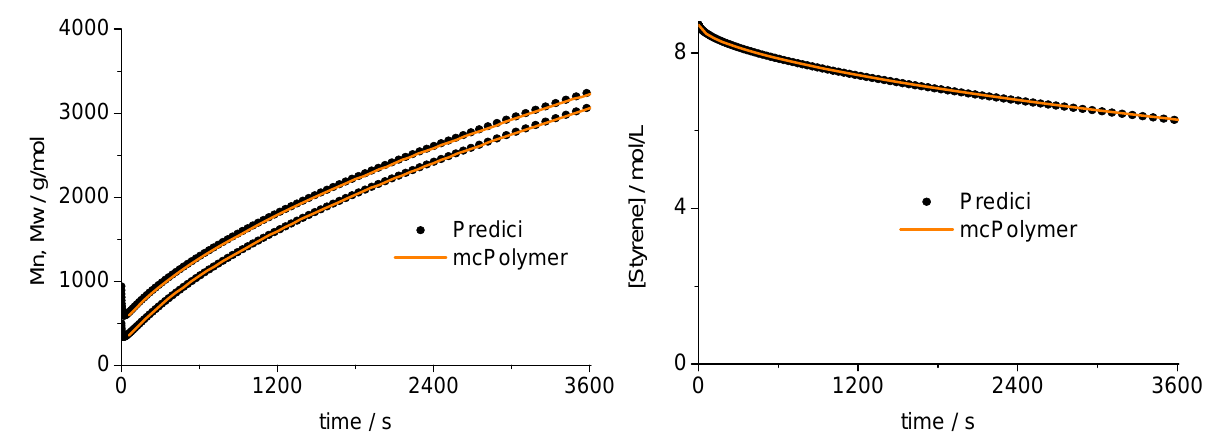
Table 9. Performance analysis; reaction time = 1 h; [RX]